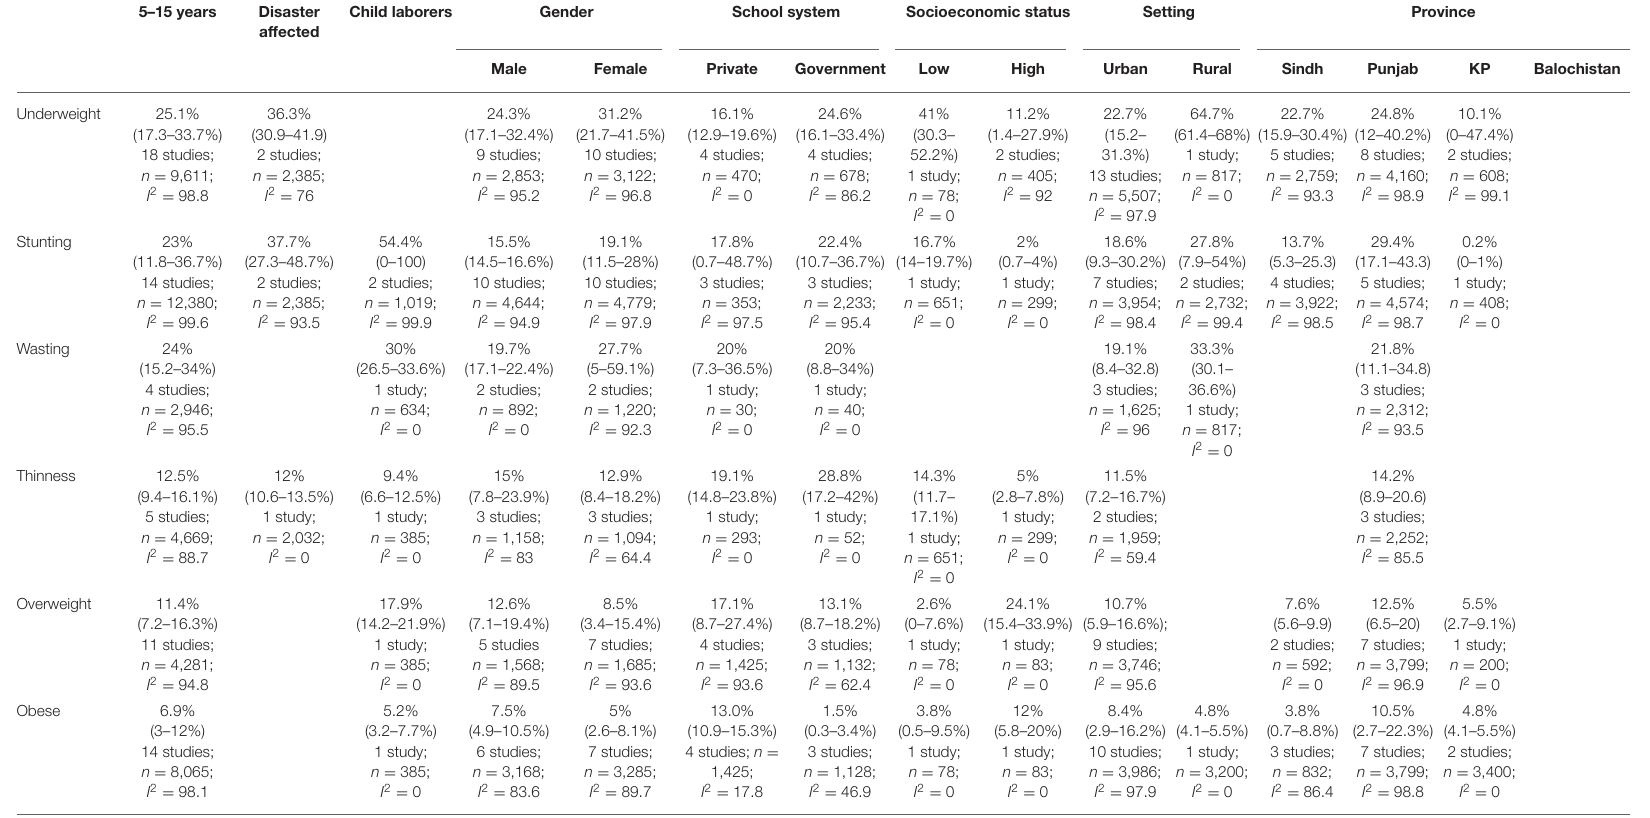
TABLE 4 | Setting specific anthropometric indices in children age 5–15